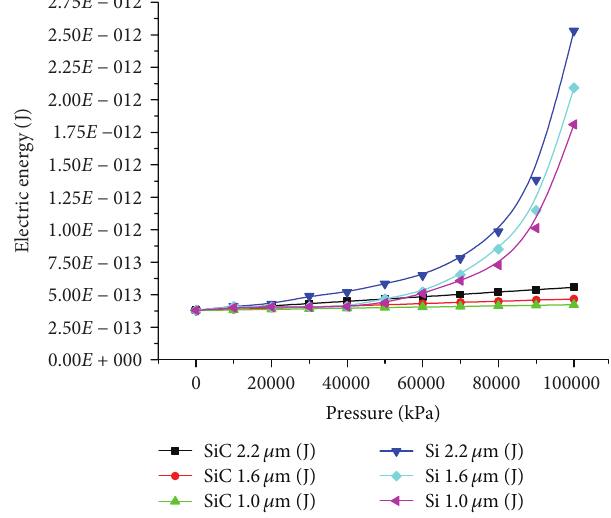
Figure 17: Comparison of total electric energy versus pressure for 3C-SiC and Si with differential thickness of